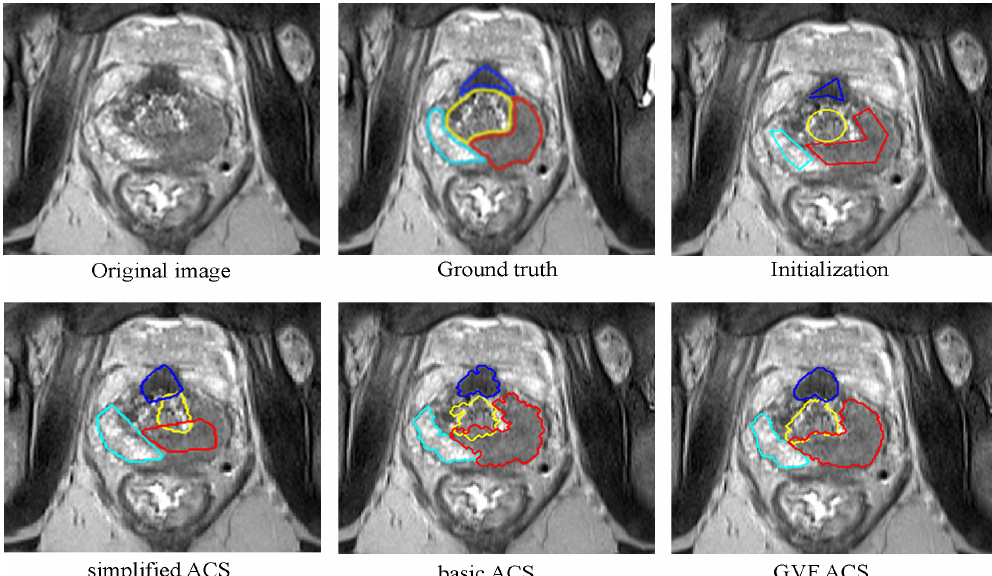
Figure 12. Segmentation results and ground truth for all the algorithms